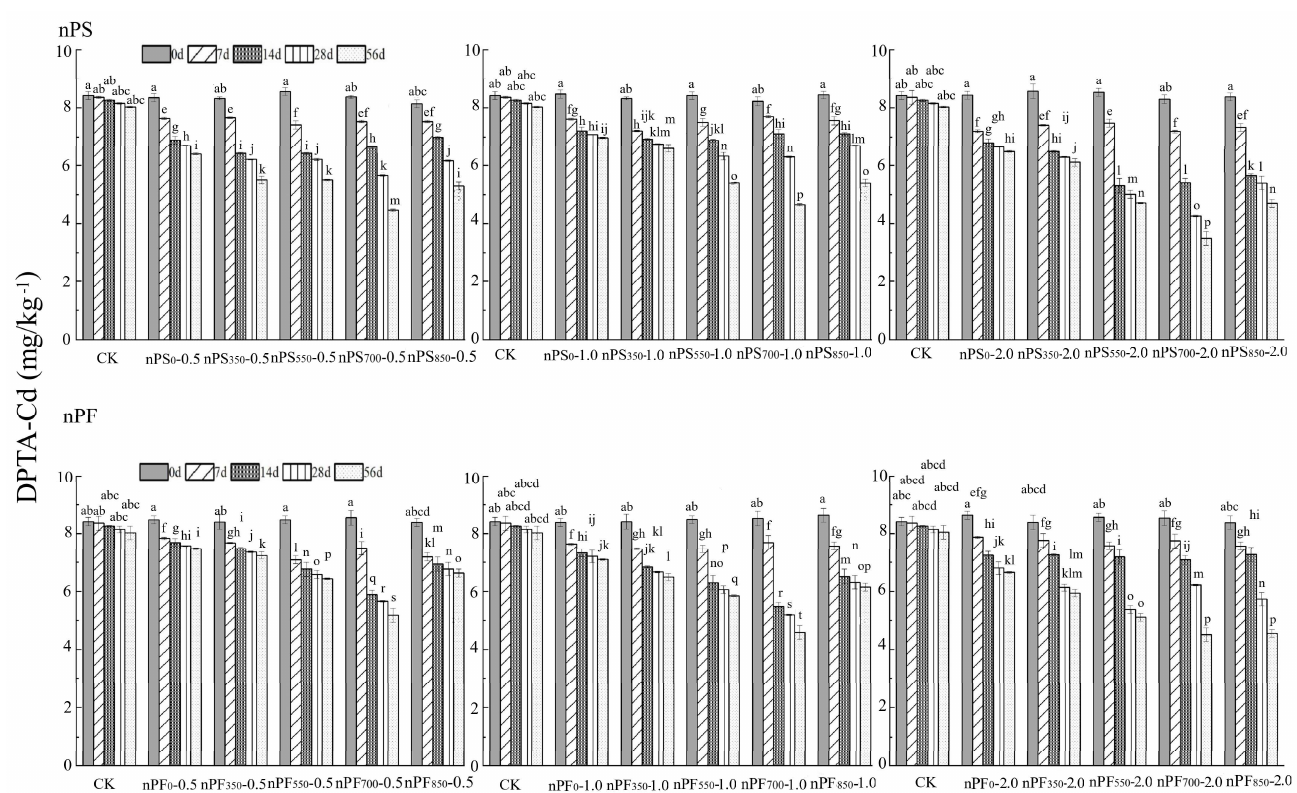
Figure 2. Effect of different treatments on the soil’s DTPA-Cd content. n = 3, Different lower-case letters marked in Figure 2 indicate a significant difference across different treatments ( p < 0.05). Error bars ( n = 3, Mean ± SD).